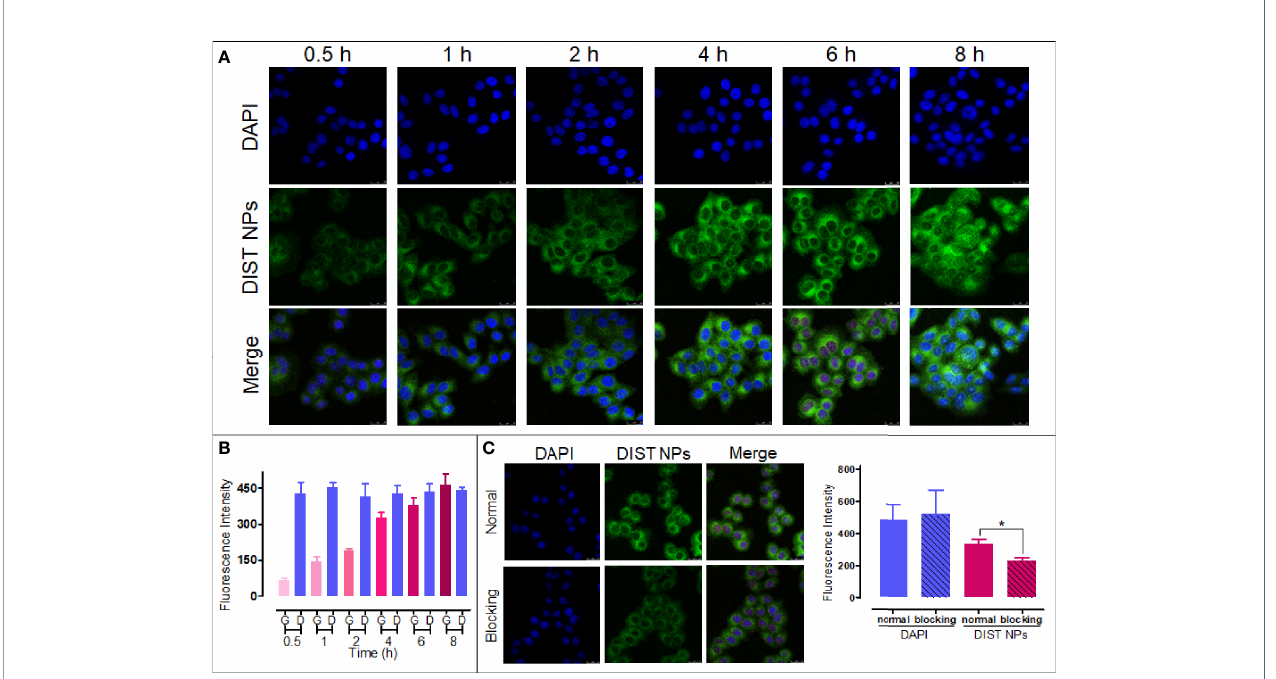
FIGURE 3 | The cell endocytosis test results. The endocytosis effect (A) and fl uorescence quantitative analytics (B) results of the DIST NPs. The endocytosis inhibition and fl uorescence quantitative analytics results of the DIST NPs (C) . The data of signal quantitation were extracted at more than three areas. The * represents p <